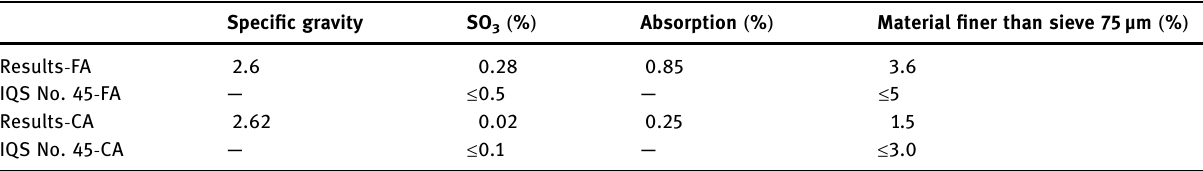
Table 4: Properties of FA and CA